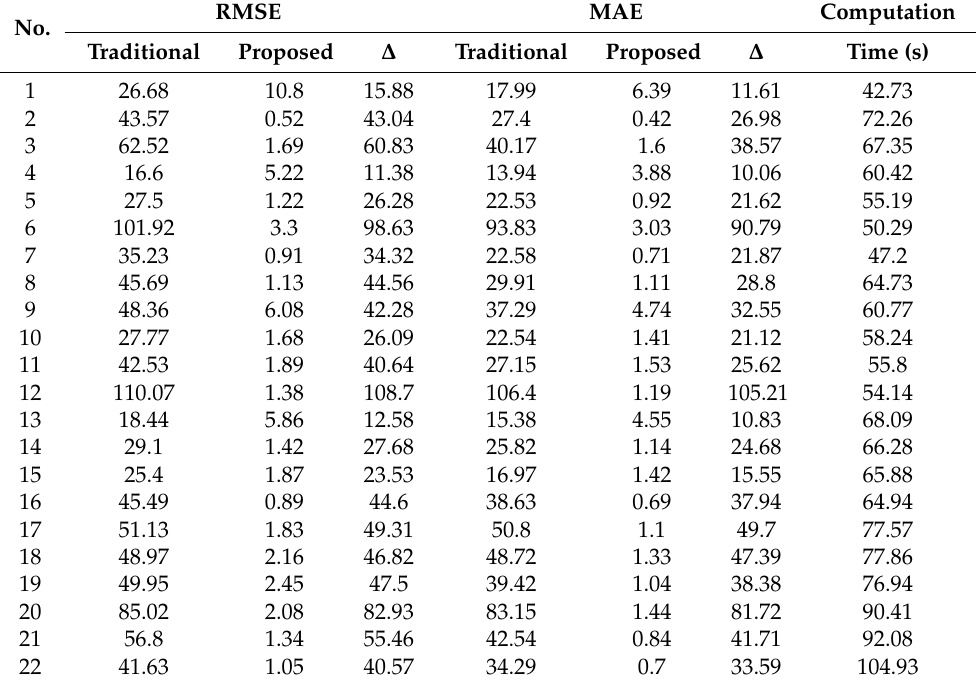
Table A2. Performance comparison for medium-term solar power forecasting (August) by the models.